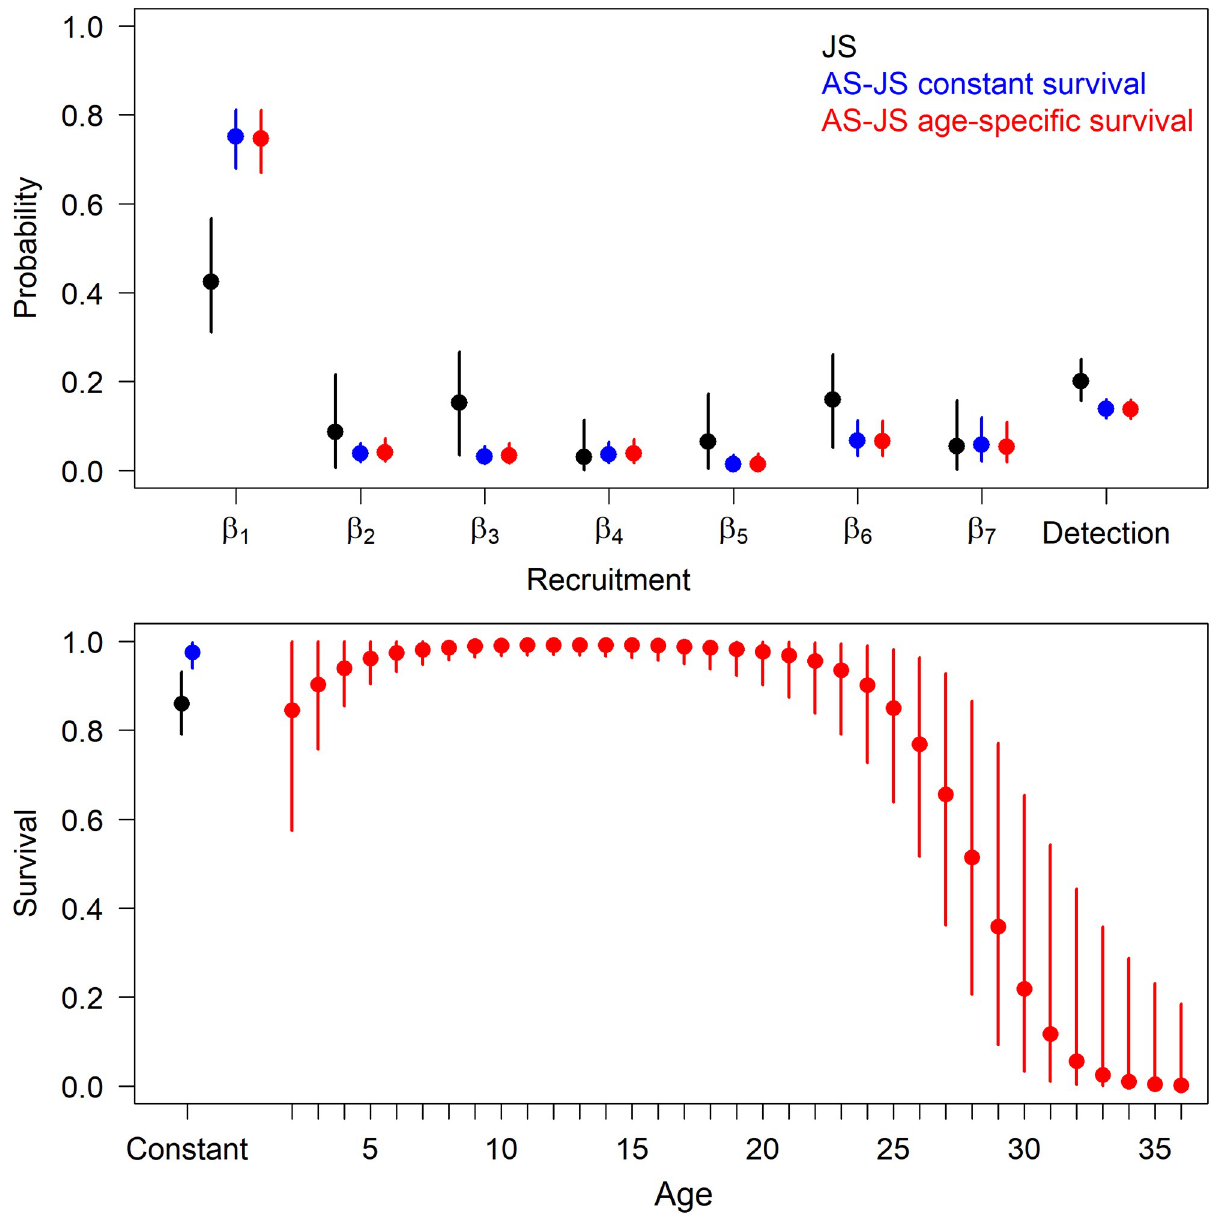
Fig 3. Recruitment and detection probabilities (top) and annual survival (bottom) of western Hudson Bay polar bears from Jolly-Seber models that ignore age structure (black) or incorporate age structure and assume annual survival is constant (blue) or a quadratic function of age (red). Points and error bars are posterior medians and 95% credible intervals,